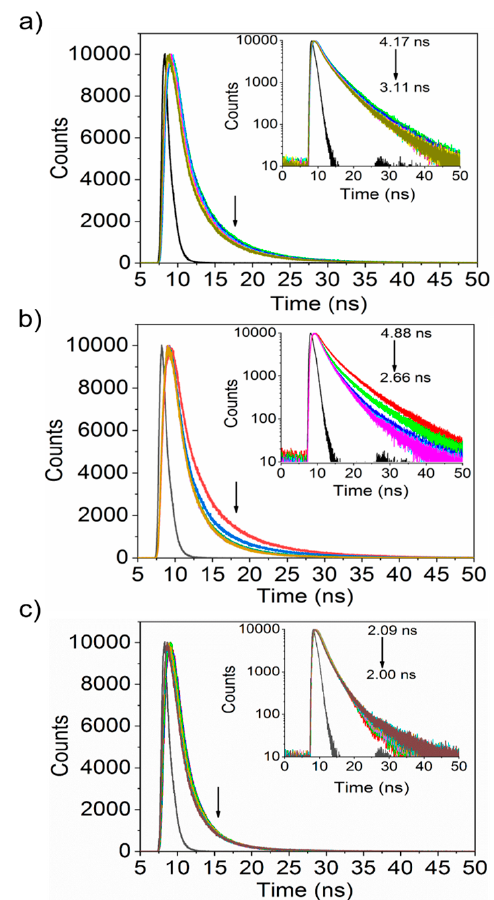
Figure 5. PL decay profiles of human serum albumin ( a ), fibrinogen ( b ), and transferrin ( c ) with the incremental addition of SiQDs / F127 nanoparticles. Arrows indicate the decrease of PL decay time with the gradual addition of nanoparticles.